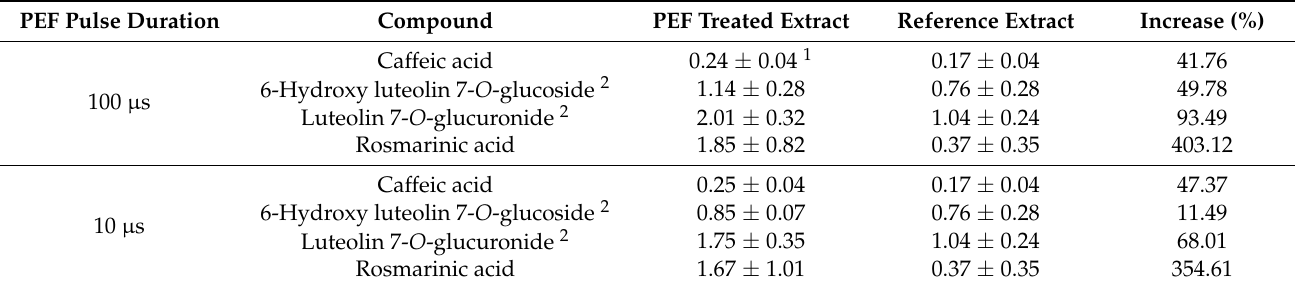
Table 3. Major compounds (mg g − 1 dw) of Salvia officinalis L. PEF treated (pulse duration of 100 μs ) and reference extracts, all prepared with 25% ethanol.